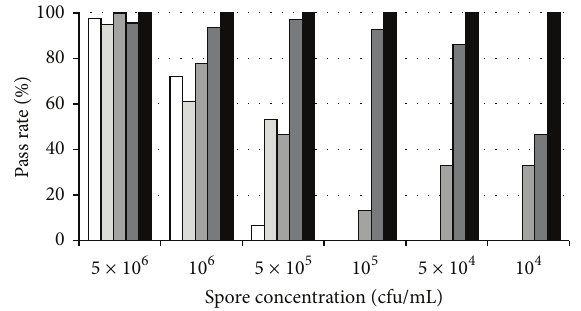
Figure 3: PHAD detection rate compared to LFDs and ELISA. Three LFDs Tetracore, Advnt, and New Horizons; white, light and mediumgraybars,resp.),PHAD(darkgray)andELISA(blackbars). were assessed for type 2 error (presented here as “detection rate” or percent true positive signals) at the indicated spore concentrations. 𝑛 ≥ 15 (LFDs), 100 (PHAD), and 25 (ELISA).